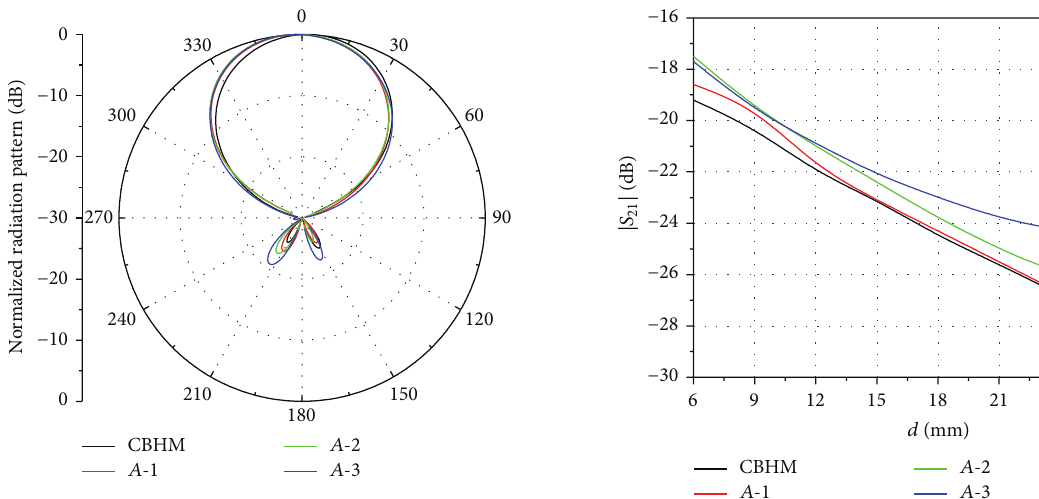
Figure 18: E -plane radiation patterns: collinear configuration.